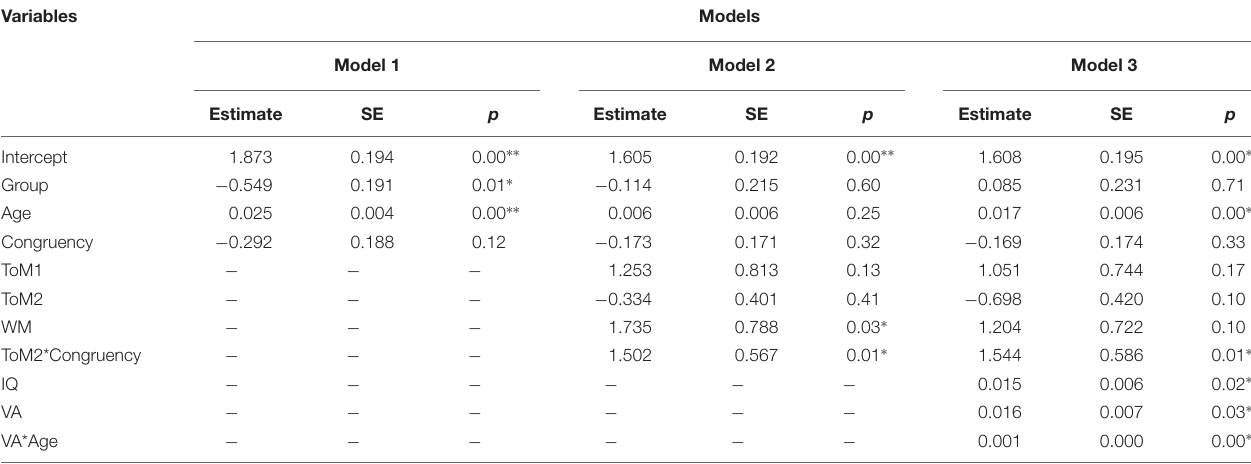
TABLE 2 | Estimated effects of variables per model on the interpretation of temporal conjunctions.